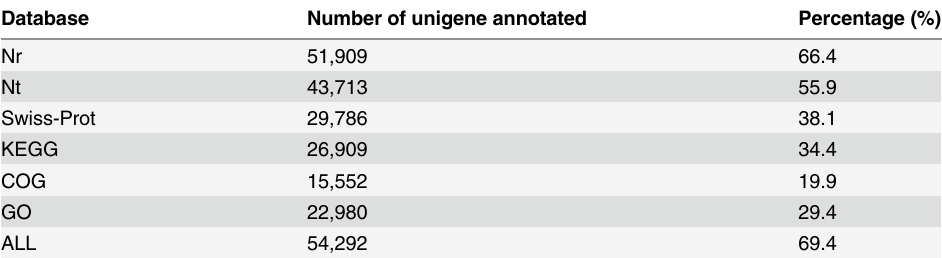
Table 2. Annotation of the American ginseng seed